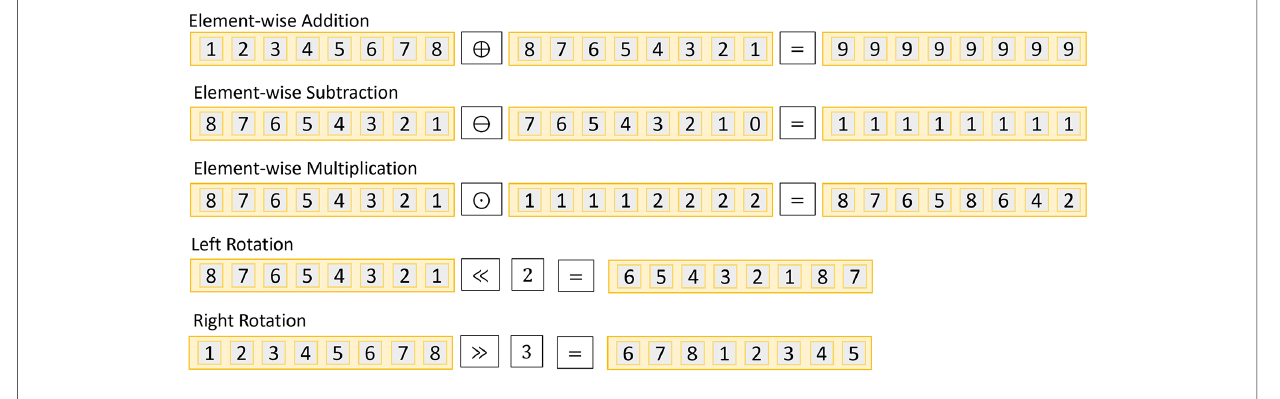
FIGURE 2 SIMD Operations allowed by CKKS Packed Homomorphic Encryption Scheme and operation scenarios for n ¼ 8 and N ¼